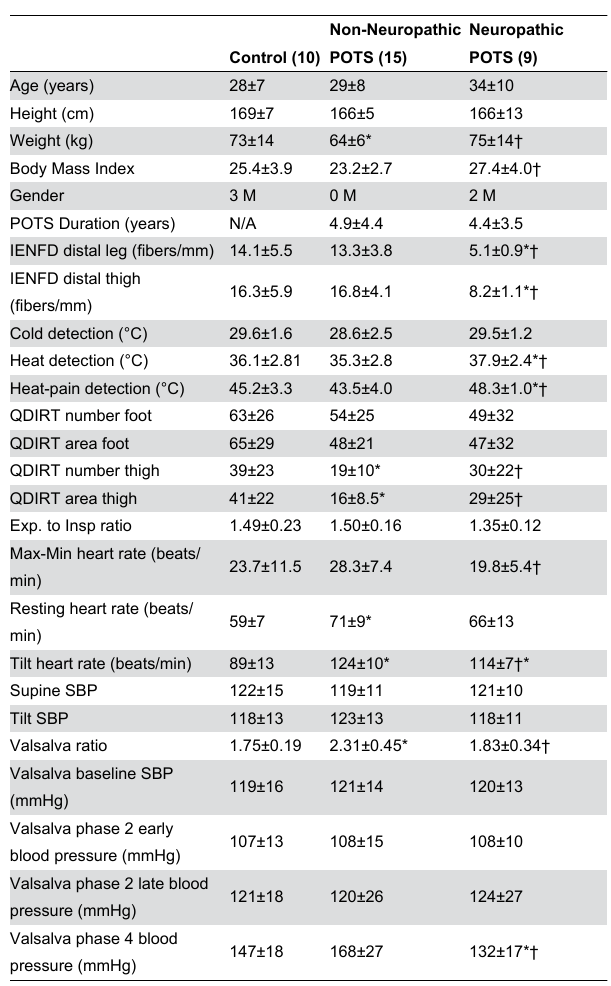
Table 1. Results for controls, neuropathic and non- neuropathic POTS subjects.